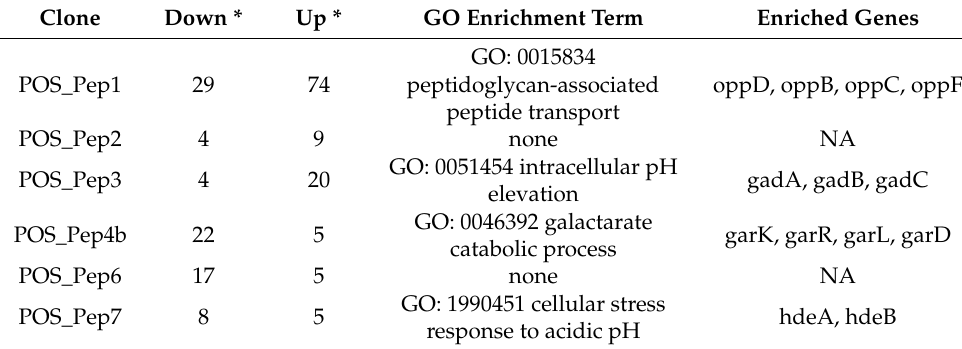
Table 1. Transcriptomic responses of cells expressing POS_Pep